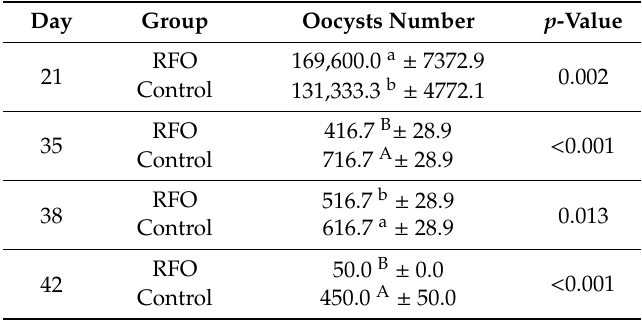
Table 7. Quantification of coccidia oocysts present in feces of in ovo injected